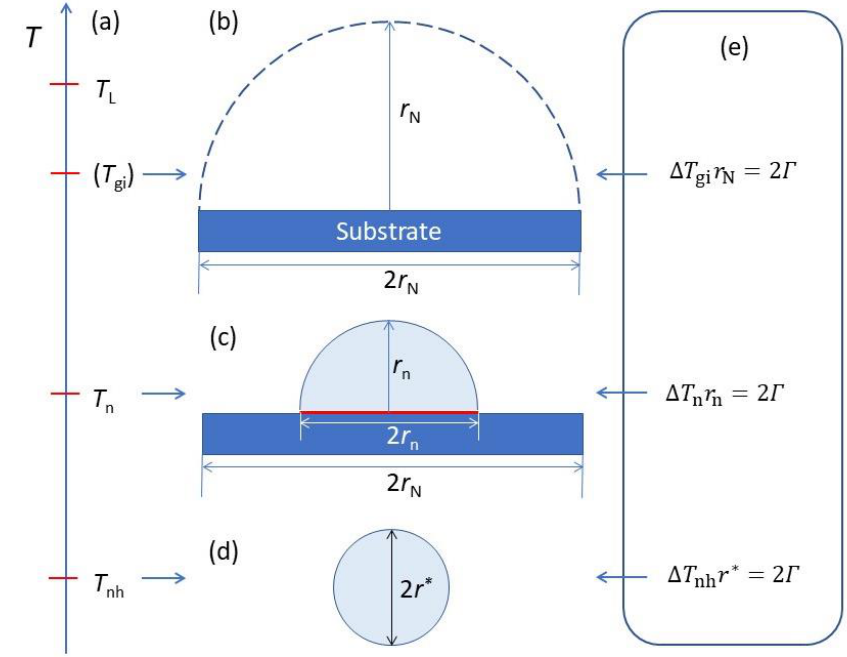
Figure 18. Schematic illustration of the relationships between grain initiation, heterogeneous nucleation and homogeneous nucleation. ( a ) Relative positions of the relevant temperatures; ( b ) constrained grain initiation; ( c ) heterogeneous nucleation and unconstrained grain initiation; ( d ) homogeneous nucleation; and ( e ) the corresponding governing equations. The dark blue rectangles represent substrates; the red rectangle is the 2D nucleus; and the light blue circles denote the solid.